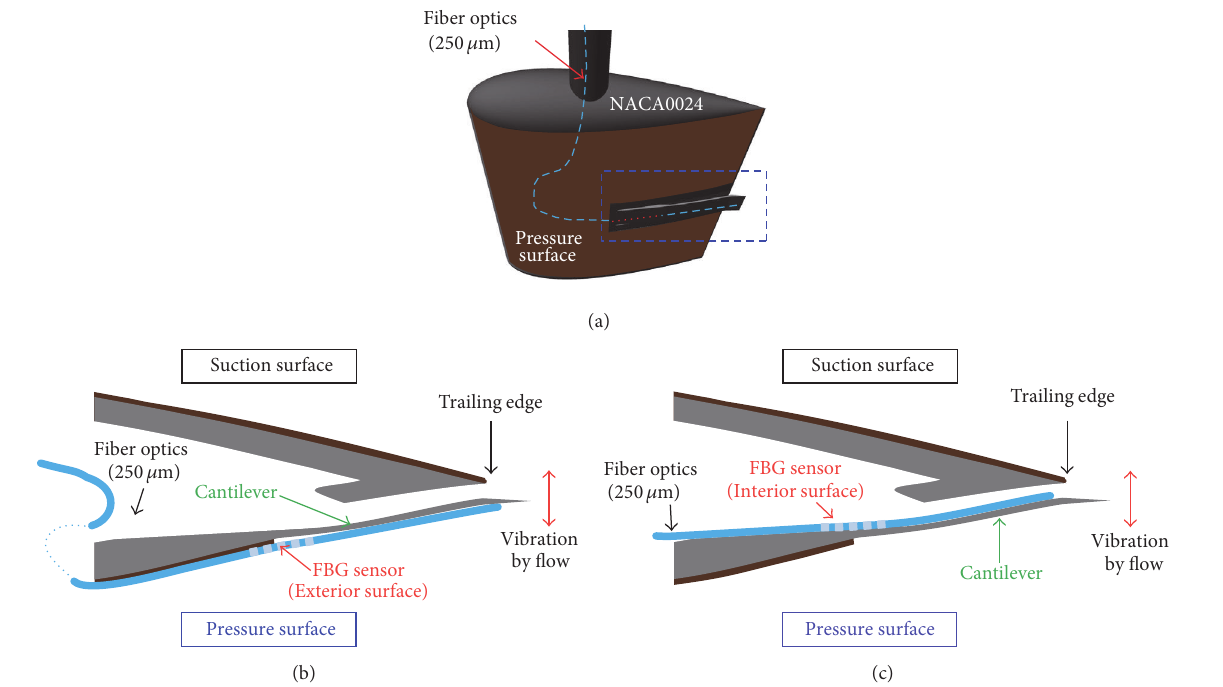
Figure 8: Schematic illustrations of FBG flow sensor constructed in pressure surface of NACA0024. (a) An optical fiber is inserted in the inside of hollow NACA0024 airfoil. Detections of flow separation are tried by attaching the FBG sensor (b) on exterior surface of cantilever and (c) on interior surface of cantilever.